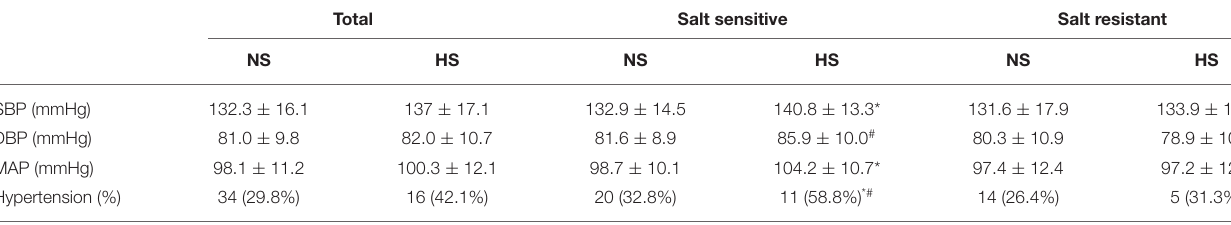
TABLE 2 | The effect of high salt intake on blood pressure level and prevalence of hypertension according to salt sensitivity.